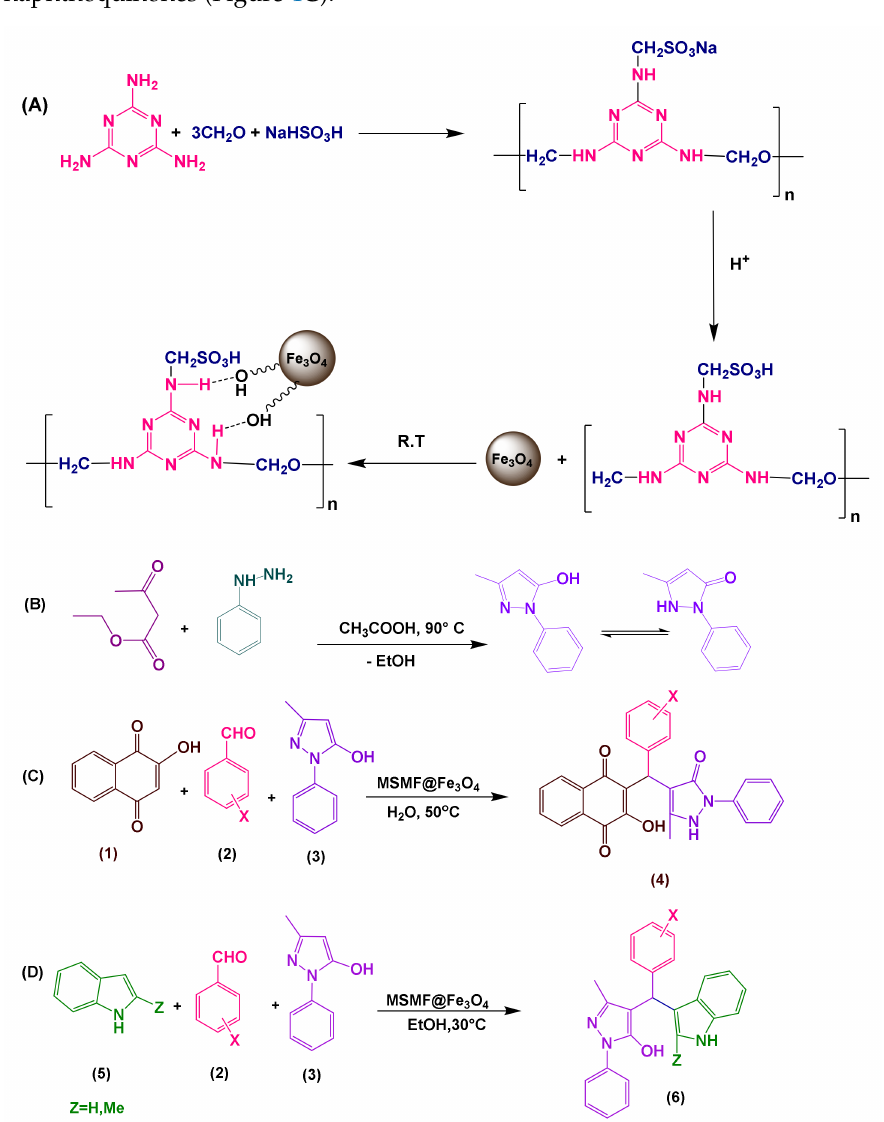
Figure 4. Synthesis of MSMF in two steps ( A ); synthesis of 3-methyl-1-phenyl-1 H -pyrazol-5-ol ( B ); synthesis of benzyl pyrazolyl naphthoquinones from aldehyde, 3-methyl-1-phenyl-1 H -pyrazol-5-ol, and 2-hydroxy naphthoquinone ( C ); synthesis of 4-[(indol-3-yl)-arylmethyl]-1-phenyl-3-methyl-5- pyrazolones from aldehyde, 3-methyl-1-phenyl-1 H -pyrazol-5-ol, and indole ( D ).